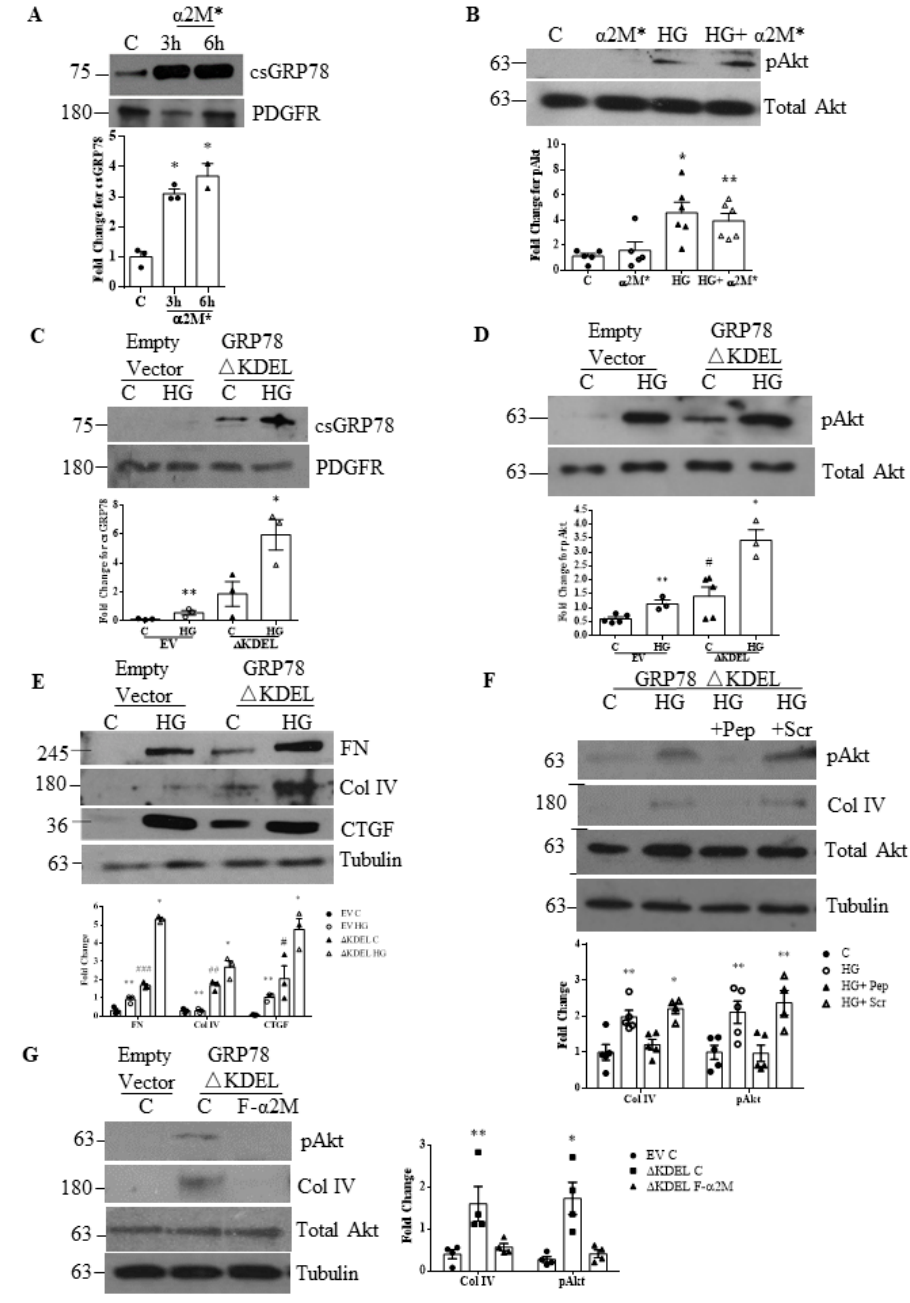
Figure 6. Increased matrix synthesis with csGRP78 overexpression requires α 2M*. ( A ) α 2M* (100 pM) induced cell surface expression of GRP78 at 3 and 6 h in MCs ( n = 3, * p < 0.01) ( B ) HG-induced Akt activation (pAkt on S473) was not augmented by addition of α 2M* (100 pM, 24 h) ( n = 6, ** p < 0.05 or * p < 0.01 vs. control). ( C ) Increased translocation of GRP78 to the cell surface was induced by overexpression of GRP78 lacking KDEL (GRP78 △ KDEL) in MCs. ( D ) This increased both basal and high glucose (HG, 48 h)-induced Akt activation (pAkt on S473). ( E ) Similar findings were seen with HG (48 h)-induced fibronectin (FN), collagen (Col) IV, and CTGF upregulation (for C,D,E: n = 3 except for D: n = 5, ** p < 0.05 vs. empty vector control (significant through t test) or * p < 0.01 vs. △ KDEL vector control, # p < 0.05 or ## p < 0.01 or ### p < 0.01 vs. empty vector control). ( F ) The augmented responses to HG seen with GRP78 △ KDEL overexpression, including Akt activation (pAkt on S473) and collagen (Col) IV upregulation, were prevented by the α 2M*/csGRP78 inhibitory peptide, but not the scrambled control peptide ( n = 5, ** p < 0.05 or * p < 0.01). ( G ) Similar inhibition was seen with α 2M* neutralization using F α 2M (2 μ g/mL) ( n = 4, ** p < 0.05 or * p < 0.01).